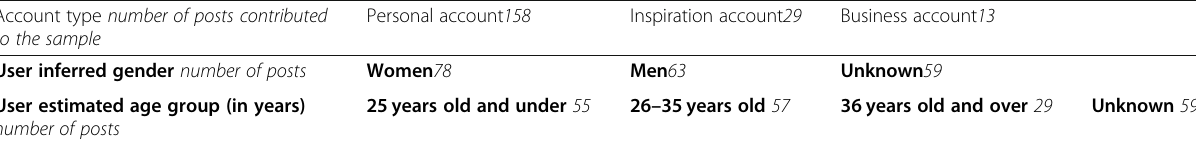
Table 1 User demographics for 200 Instagram posts tagged #goodlife a Account type number of posts contributed to the sample